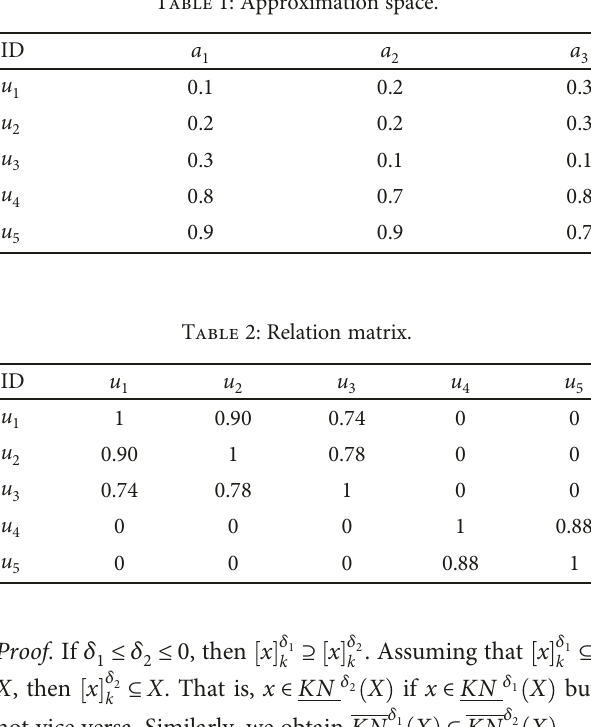
Table 1: Approximation space.